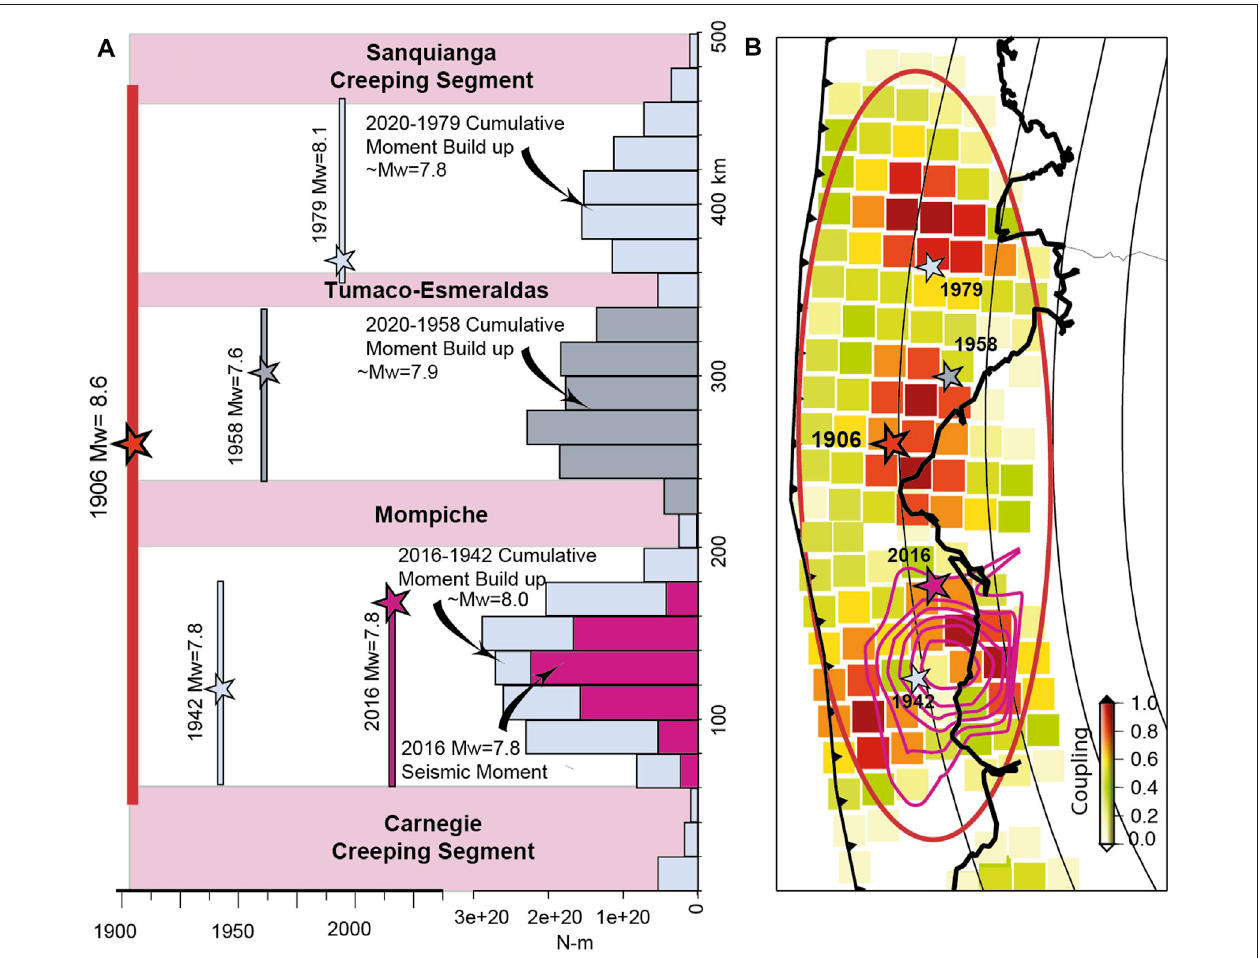
FIGURE7| Comparisonofthecumulativeinterseismicmomentbuildup(inN.m)since1942,1958,and1979withtheseismicmomentreleased(inN.m)associated with the 2016 Mw (cid:1) 7.8 Pedernales earthquake. (A) Along-trench cumulative moment buildup (in N m, N.m) between 1942 and 2016 in the Pedernales segment, between 1958and 2020in the Esmeraldas segment, and between 1979and 2020in the Tumaco segment. We consider asteady state interseismic process (i.e., linear with time). We found that the cumulative moment buildup since 1942 is about twice larger than the 2016 seismic moment released, suggesting that the 2016 Pedernales earthquake was well expected. In 2020, the moment buildup in the 1958 and 1979 rupture areas is equivalent to an Mw (cid:1) 7.9 event and to an Mw (cid:1) 7.8 event, respectively. (B) Map of the average interseismic coupling model used to integer the moment buildup in (A) . Seismic slip contours of the 2016 Mw (cid:1) 7.8 Pedernales event are reported in purple from Figure 6A . The 2016 rupture area overlaps relatively well the 1942 rupture area and is bounded northward by the Mompiche creeping segment and southward by the Carnegie creeping segment.